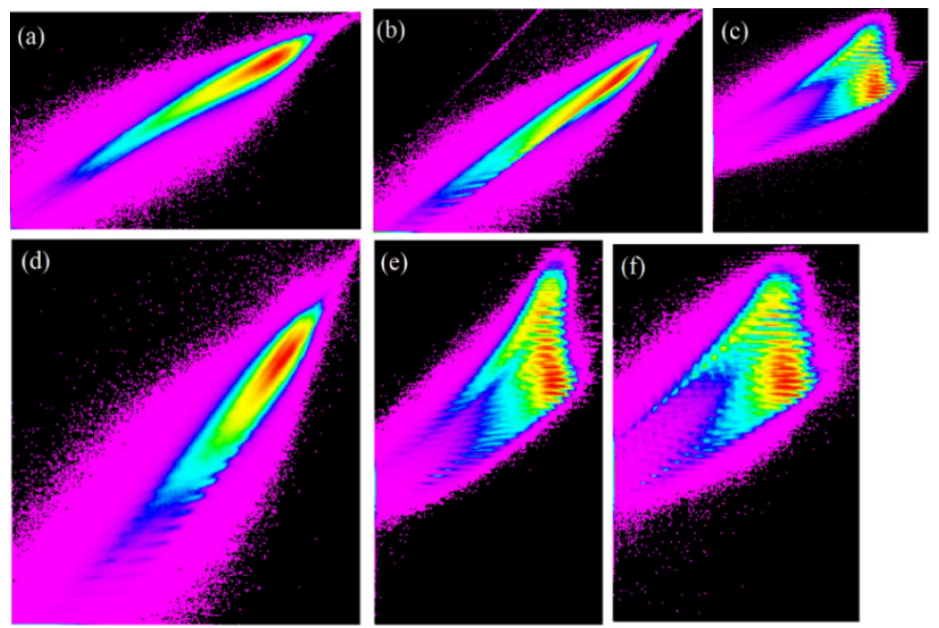
Figure 9. Scatterplot of ET on 5 August 2001 estimated using different ET models for cropland showing ( a ) METRIC model versus SEBAL model; ( b ) METRIC model versus SEBS model; ( c ) METRIC model versus SSEBop model; ( d ) SEBAL model versus SEBS model; ( e ) SEBAL model versus SSEBop model; and ( f ) SEBS model versus SSEBop model. Axes values are ET (mm) such as diagonal line will represent 1:1 line. Different colors in the scatterplots indicate density of points with red being the highest density and magenta being the least density.